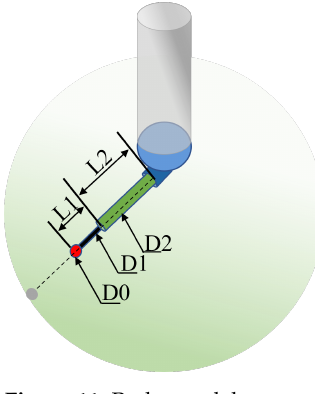
Figure 11. Probe model. Table 1. Parameters of the CMM and